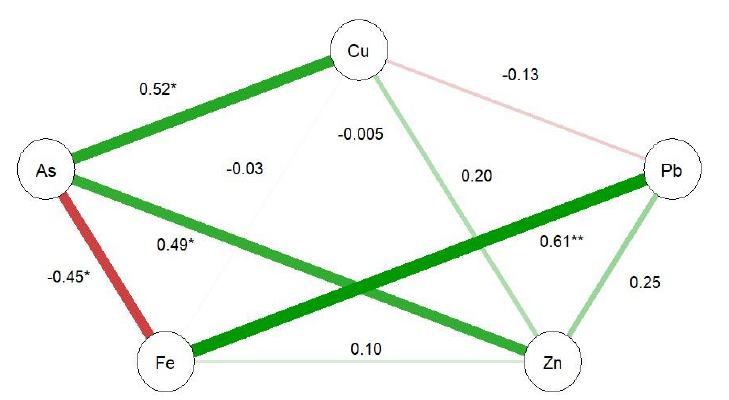
Figure 2. Spearman correlation matrix between heavy metals and arsenic in river water with mining influence.